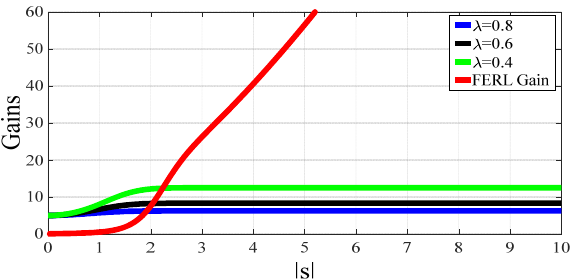
Figure 1. Gains of different methods. FERL: fast exponential reaching law.